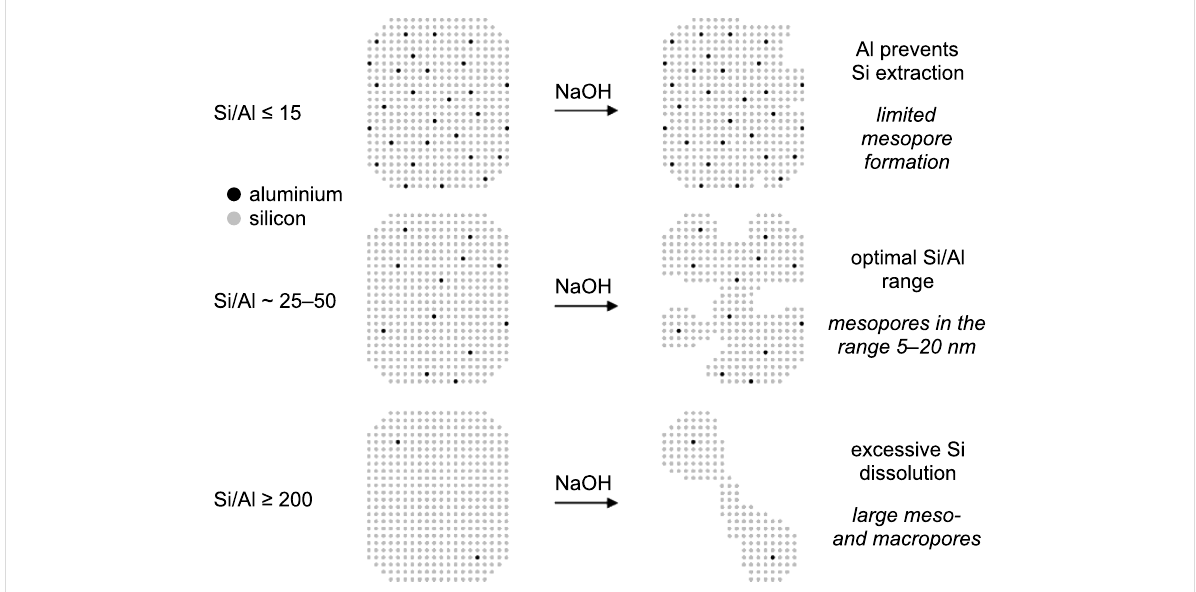
Figure 2: A simplified representation of the influence of the Al content on the desilication of ZSM-5. Reprinted with permission from [66]. Copyright 2004 American Chemical Society.